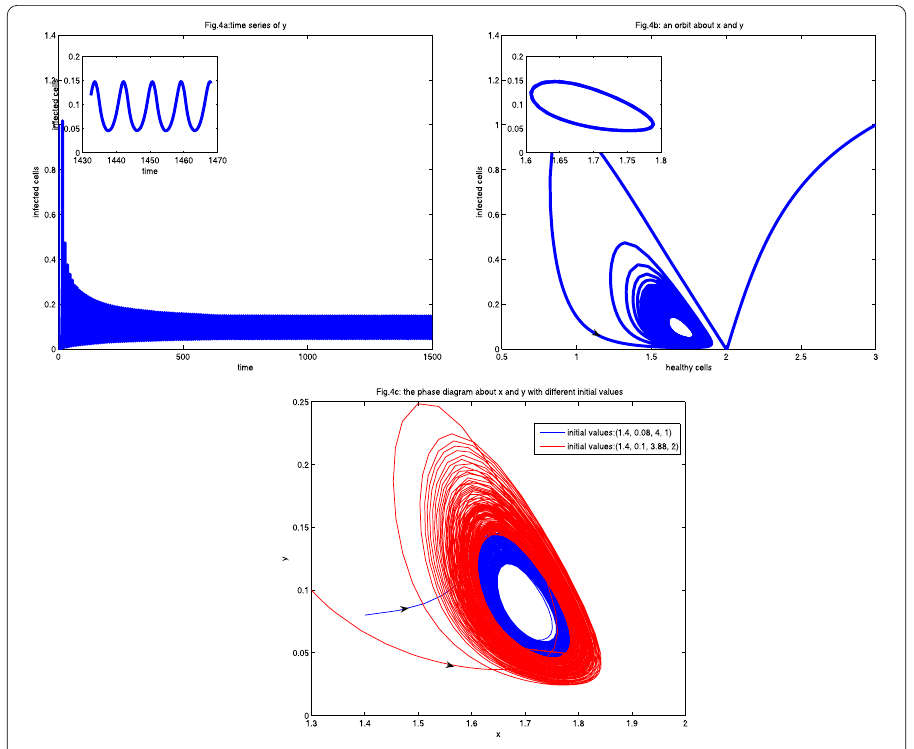
Figure 4 Figure 4( a ) is the diagram of time series of y at a = 0.31 with initial value (3,1,2,4). Figure 4( b ) is a part of the phase diagram about x and y with the same initial values. Figure 4( c ) is the phase diagram with different initial values